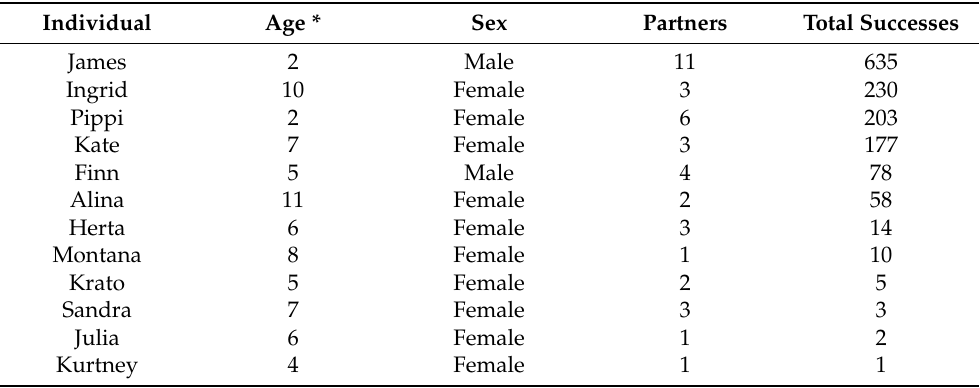
Table 1. Summary of results by